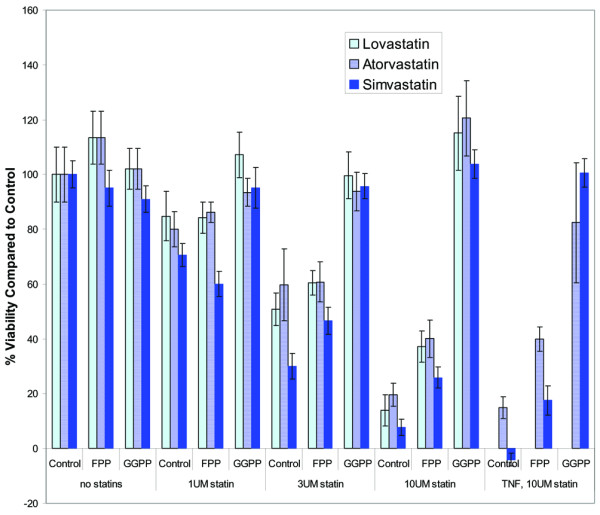
Geranylgeranylpyrophosphate (GGPP) restores the viability of synovial fibroblasts in the presence of statins. Synovial fibroblasts were cultured for 96 hours in the presence of 1, 3 or 10 μM lovastatin, atorvastatin or simvastatin supplemented with 5 μM farnesylpyrophosphate (FPP) or 5 μM GGPP, or neither FPP nor GGPP (control). XTT assays were performed on quadruplicate wells to determine the percentage cellular viability of treated in comparison with non-treated cultures. Each treatment was performed on two different synovial fibroblast lines. A representative experiment is shown. In a separate experiment, synovial fibroblasts were pretreated with 10 ng/ml tumor necrosis factor-α for 24 hours before the addition of 10 μM atorvastatin or simvastatin and 5 μM FPP or 5 μM GGPP. They were cultured for a further 96 hours before an XTT assay on quadruplicate wells.